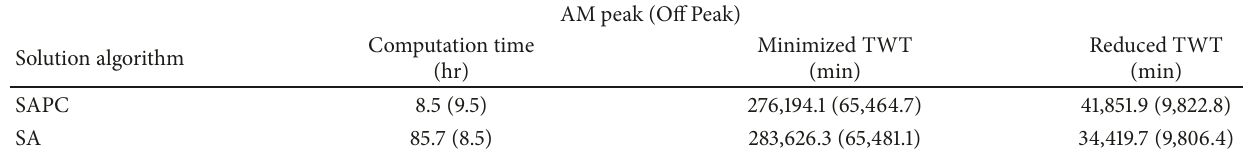
Table 4: Results from different solution algorithms. AM peak (Off Peak)